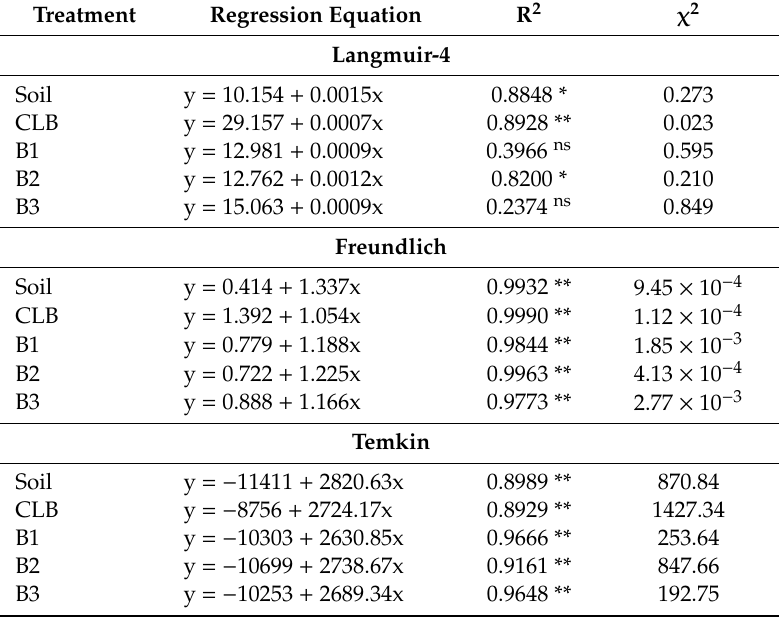
Table 12. Regression equations, Coe ffi cient of determination (R 2 ), and Chi-square analysis ( χ 2 ) for the fit of the Langmuir type 4, Freundlich, and Temkin isotherms to the nitrogen adsorption data of the